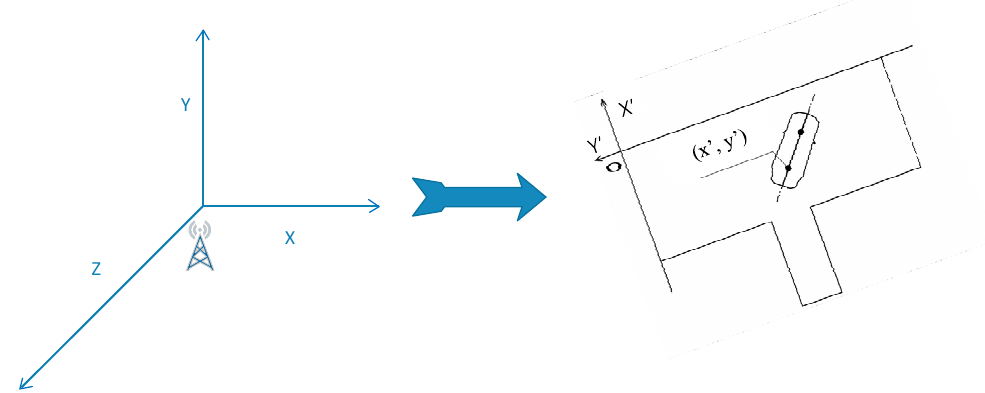
Figure 8. Coordinate transformation for the general purpose of AI-DTS.